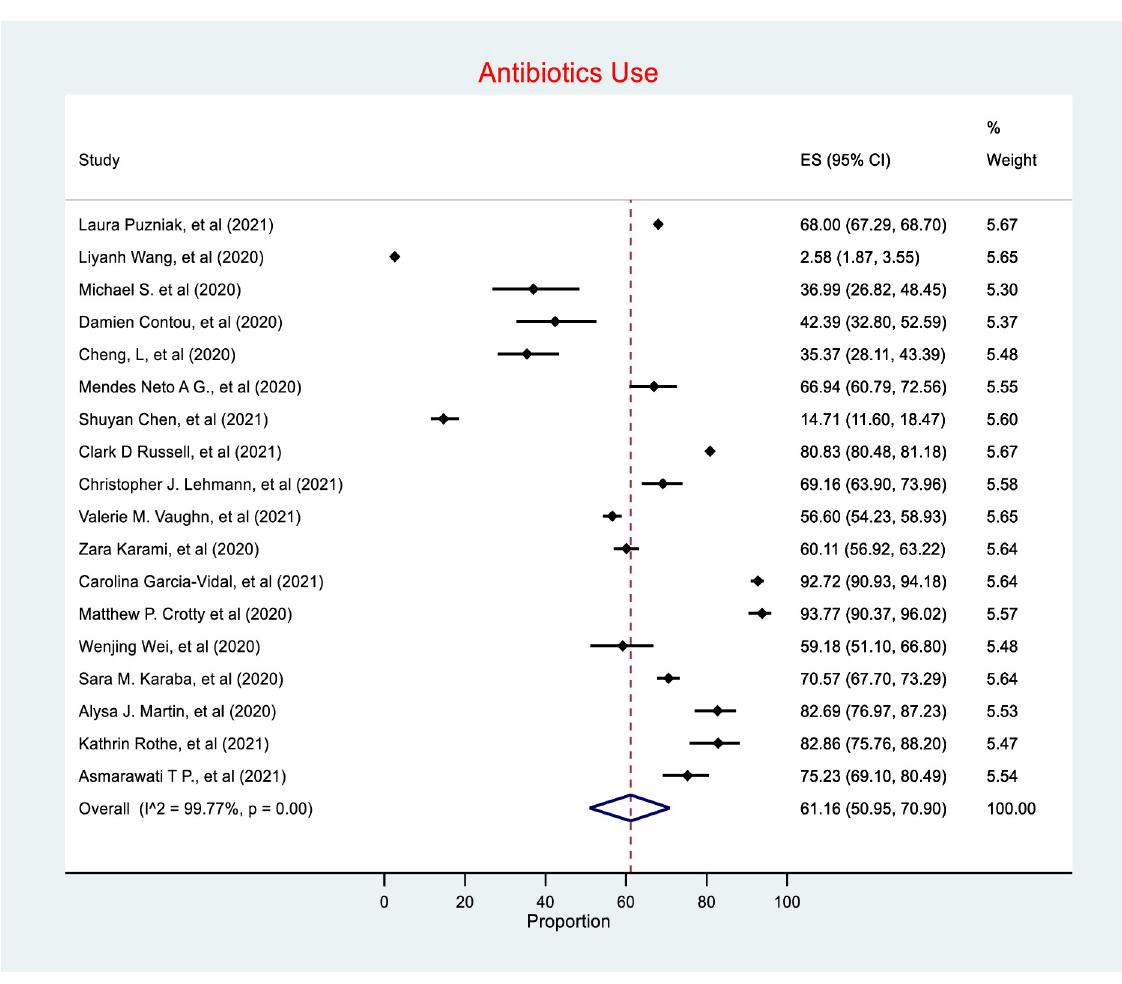
Fig 3. Antibiotic